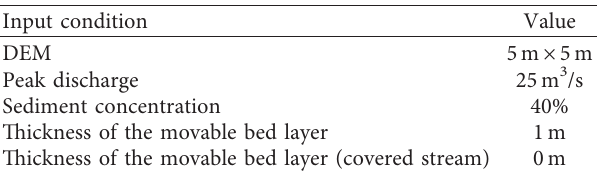
Figure 5: Debris flow peak discharge calculated by rationale method. Table 2: KANAKO-2D input conditions for debris flow simulation